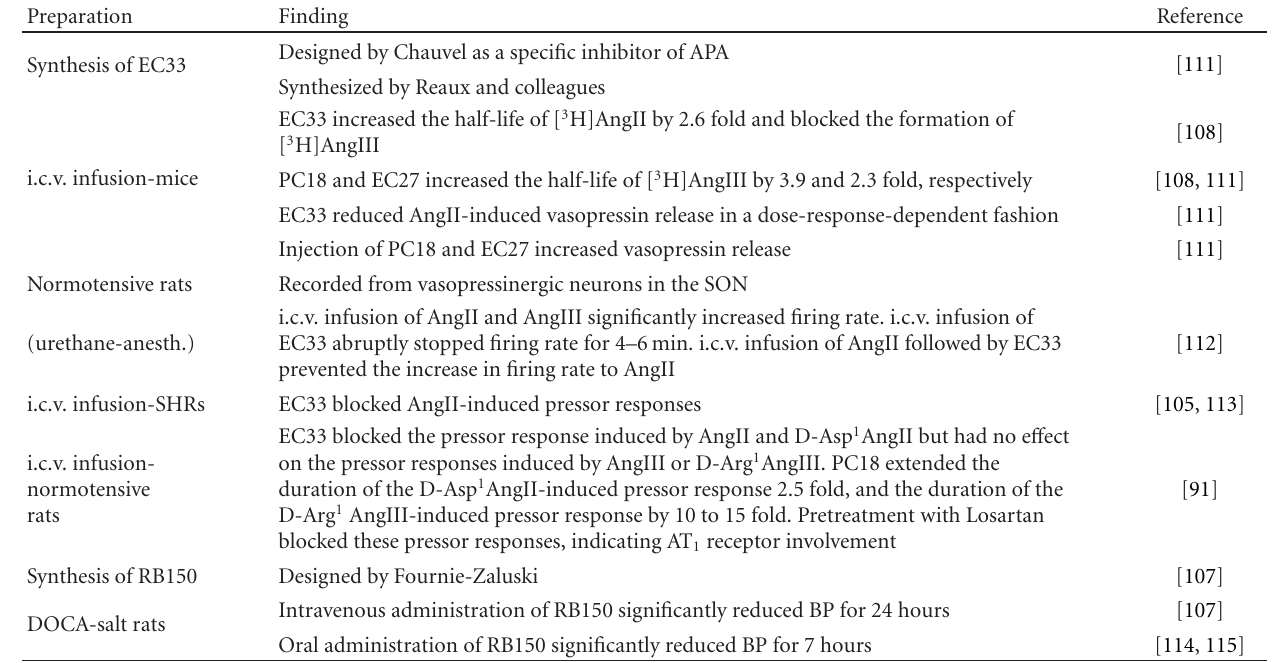
Table 2: Summary of investigations supporting a role for EC33 and PC18 (EC27) in blocking the release of vasopressin and controlling hypertension in animal